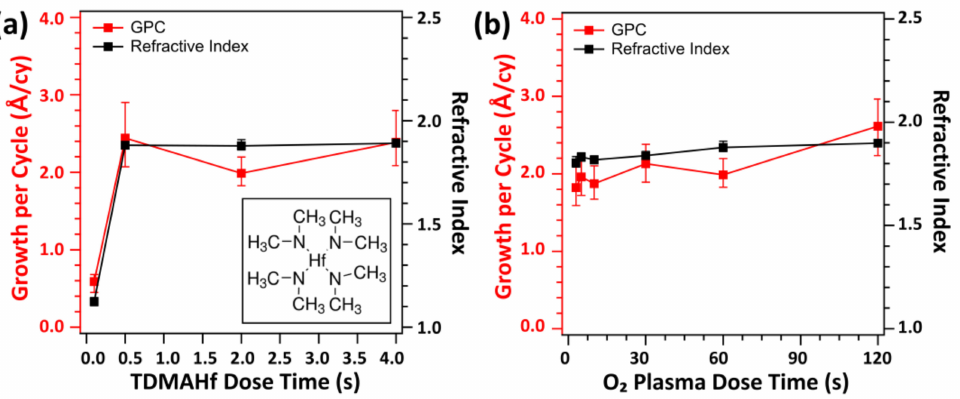
Figure 1. GPC and refractive index of HfO 2 films deposited at different conditions of ( a ) TDMAHf (inset: molecular structure of TDMAHf) and ( b ) O 2 plasma doses. For the experiment shown in ( a ), O 2 plasma condition was maintained as follows: O 2 gas flow of 50 sccm and O 2 plasma power of 20 W. For the experiment shown in ( b ), TDMAHf dose time was kept at 2